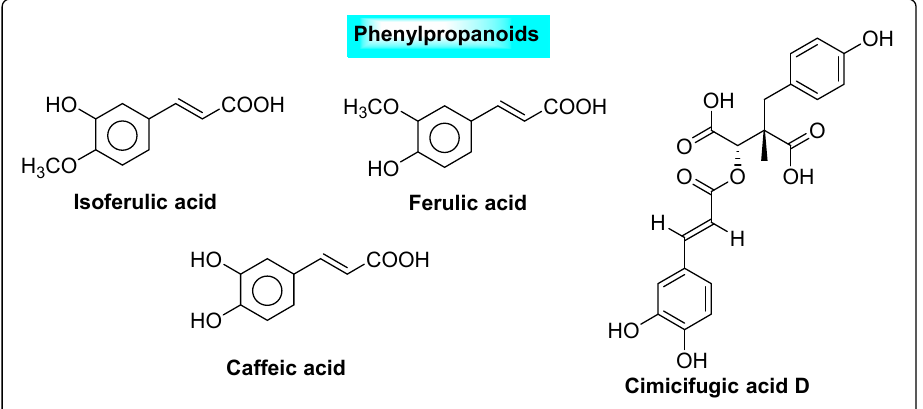
Figure 15. Phenylpropanoids present in Cimicifuga